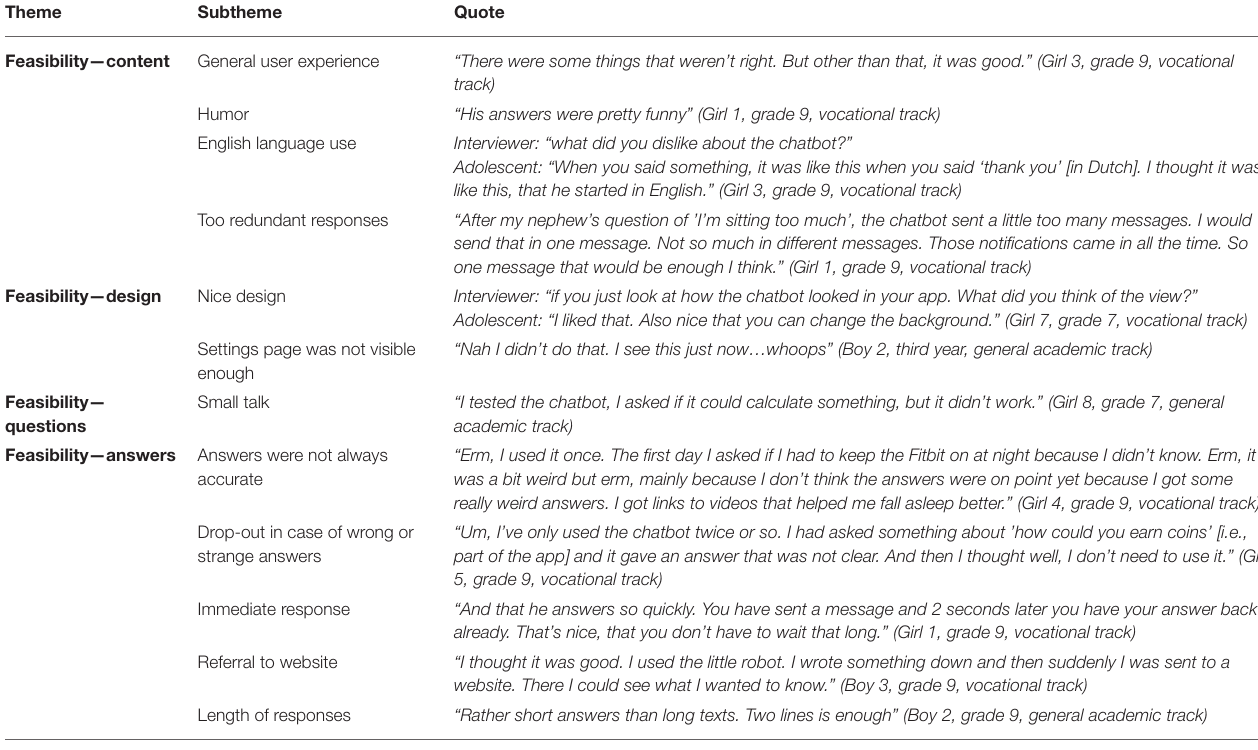
TABLE 5 | Results from the process evaluation interviews on the main theme “feasibility”. Theme